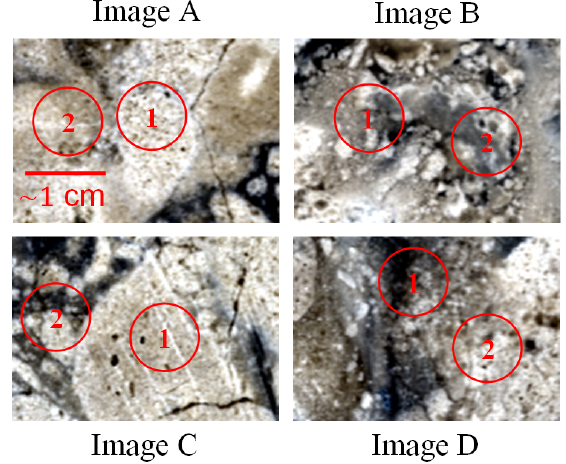
Figure 3. Selected SisuCHEMA images A, B, C, and D of carbonate rocks (bands 200, 205, and 210) with locations of two portable X-ray fluorescence (PXRF) spot measurements (red